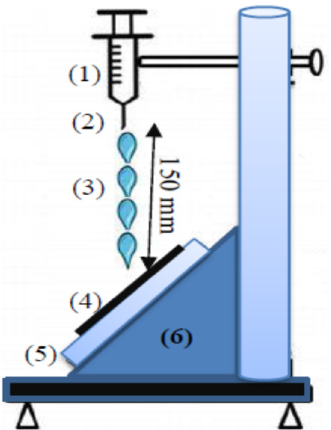
Figure 2. Schematic diagram for the water repellency spray tester containing ( 1 ) syringe, ( 2 ) jet nozzle, ( 3 ) water drop, ( 4 ) fabric sample, ( 5 ) support inclined at 45°, and ( 6 ) holder.